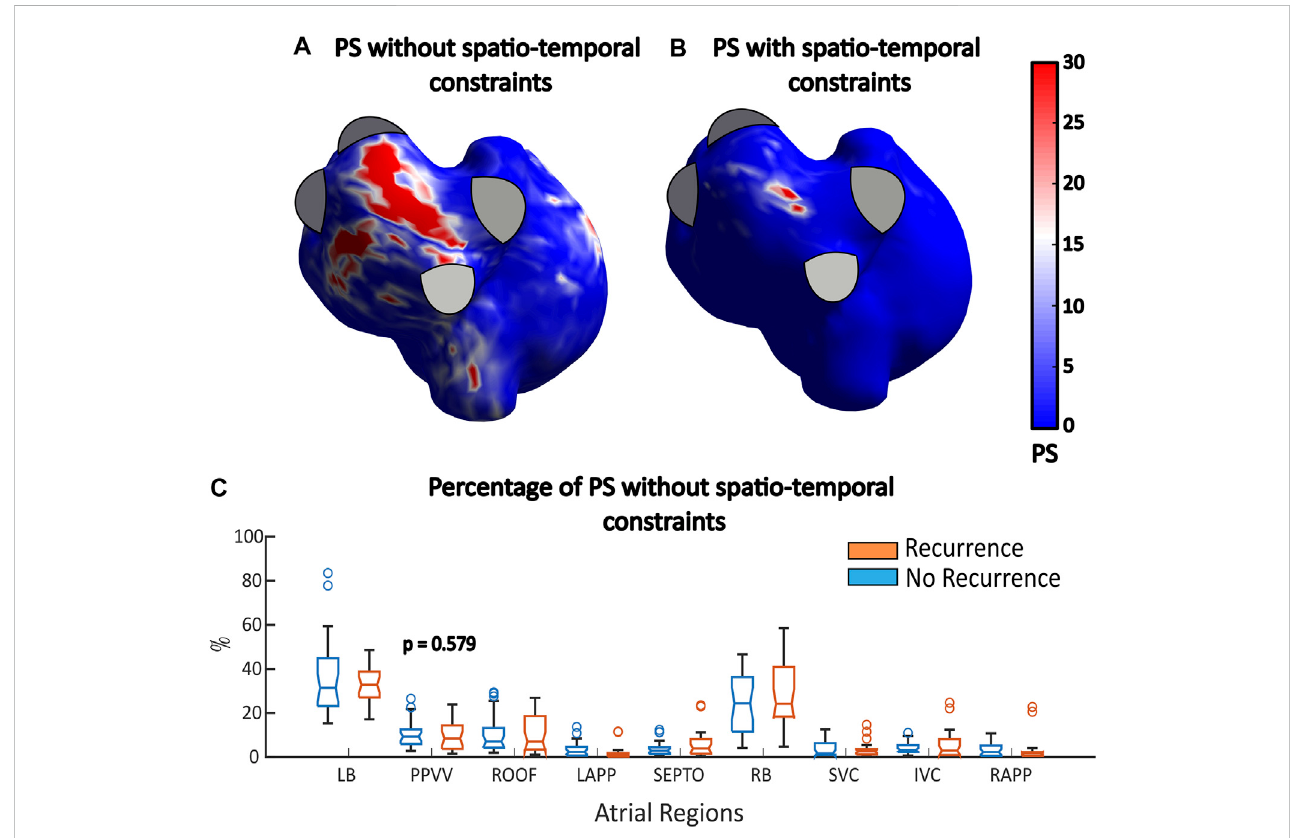
FIGURE 6 (A,B) PS histograms with and without fi ltering. (C) Percentage of PSs found in all the different atrial regions when no fi ltering strategies are applied. No statistically signi fi cant differences are